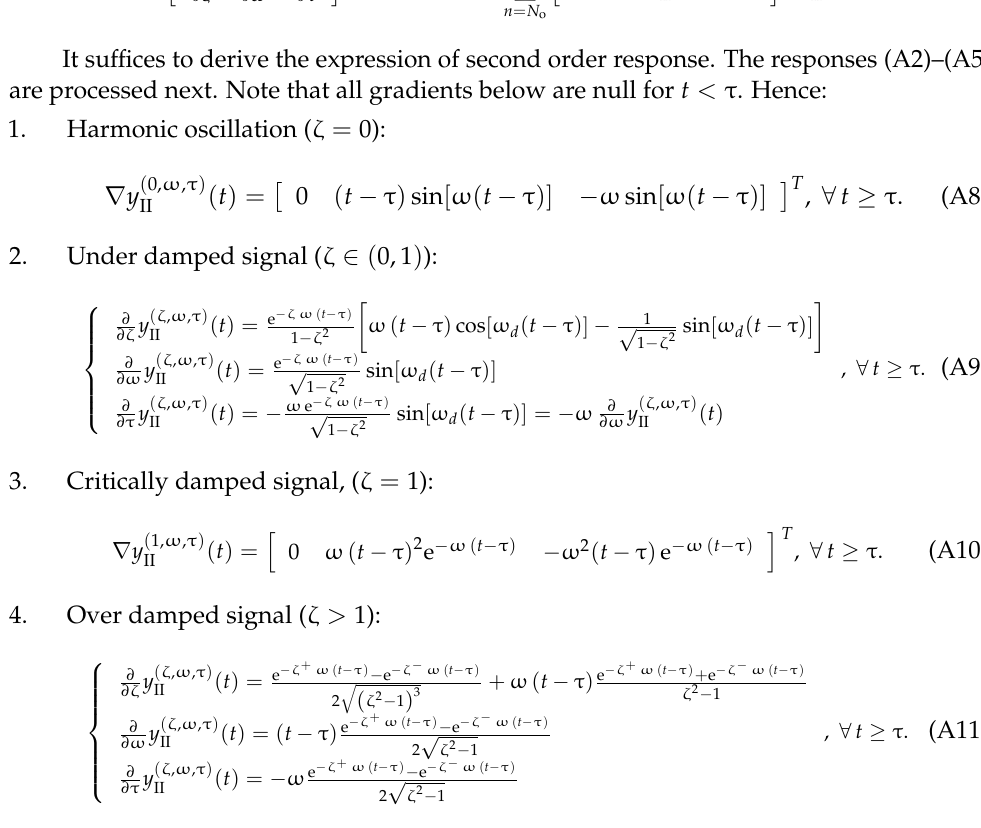
Figure A1. Quadratic criterion surfaces in identification of second order step response. The images 1 and 3 reveal how large the flat zone can be. The surface includes all four types of second order responses. For